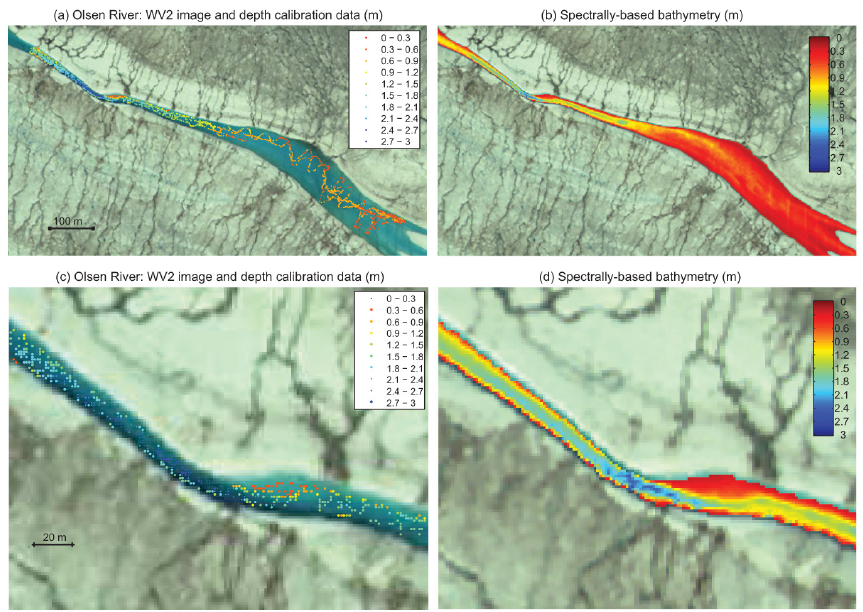
Fig. 7. Field measurements of depth from the Olsen River used for calibration (a, c) and image-derived bathymetry produced by applying the calibration equation from quadratic OBRA to the WV2 image (b, d) . Flow is from right to left.